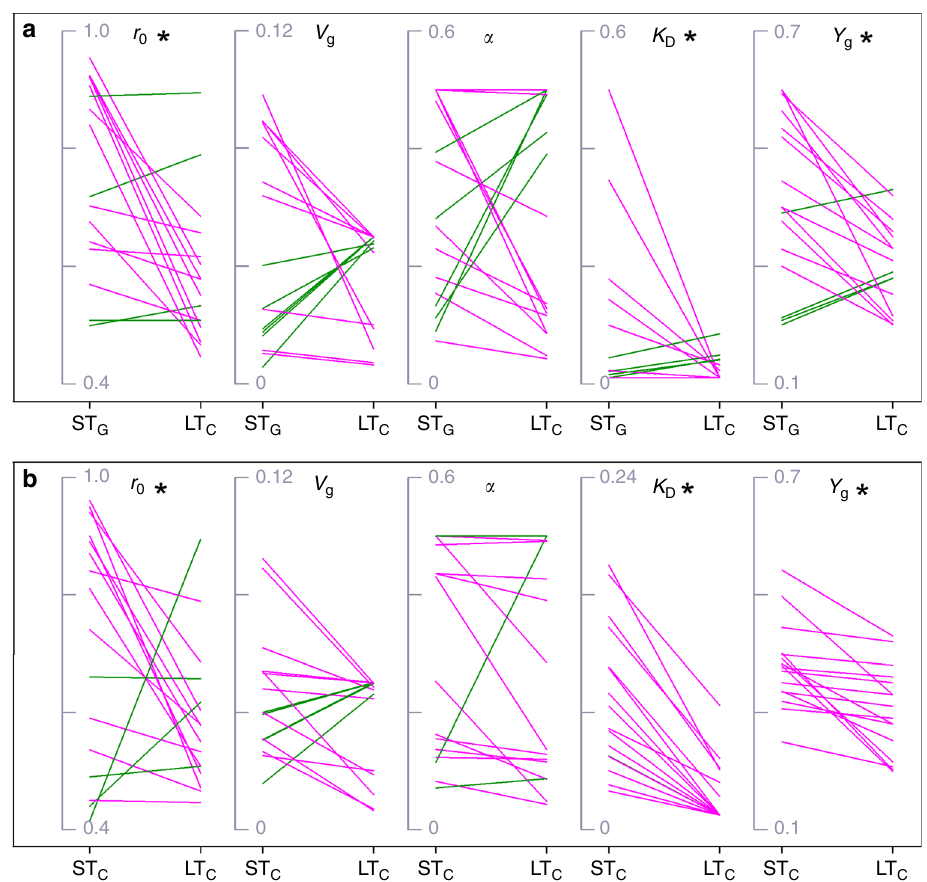
Fig. 1 Parameter estimates based on three different datasets. Estimates of fi ve best- fi t parameters (initial active fraction, r 0 ; maximum speci fi c growth rate, V g ; a ratio relating maintenance rate to growth rate, α ; half-saturation constant, K D ; intrinsic carbon use ef fi ciency, Y g ) derived from 16 short-term glucose (ST G ), 16 short-term cellulose (ST C ), and 16 long-term cellulose (LT C ) datasets. a , b denote estimates for ST G vs. LT C , and ST C vs. LT C , respectively. The two ends of each line represent the parameter values derived from the short- and long-term dataset, respectively. The pink and green lines represent the declining and increasing parameter values, respectively. Asterisks denote signi fi cant differences in the parameter values derived from the short- and long-term dataset comparisons based on the Kruskal – Wallis (KW) test at a signi fi cance level of 0.05. These were consistent across both the ST G vs. LT C and ST C vs. LT C dataset